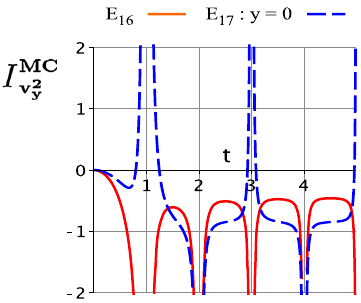
Fig. 4 Timeevolutionofthe y -componentoftheorientabilityindicator for a point electric dipole oriented in the y -direction under the same conditions as those of Fig. 3. The orientability indicator curve for E 17 also displays a characteristic inversion pattern but which is different from the one for the x -component shown in Fig. 3. For the y -component of the orientability indicator the signature of non-orientability can be recognized in the pattern of successive upward and downward “horns” formed by the dashed